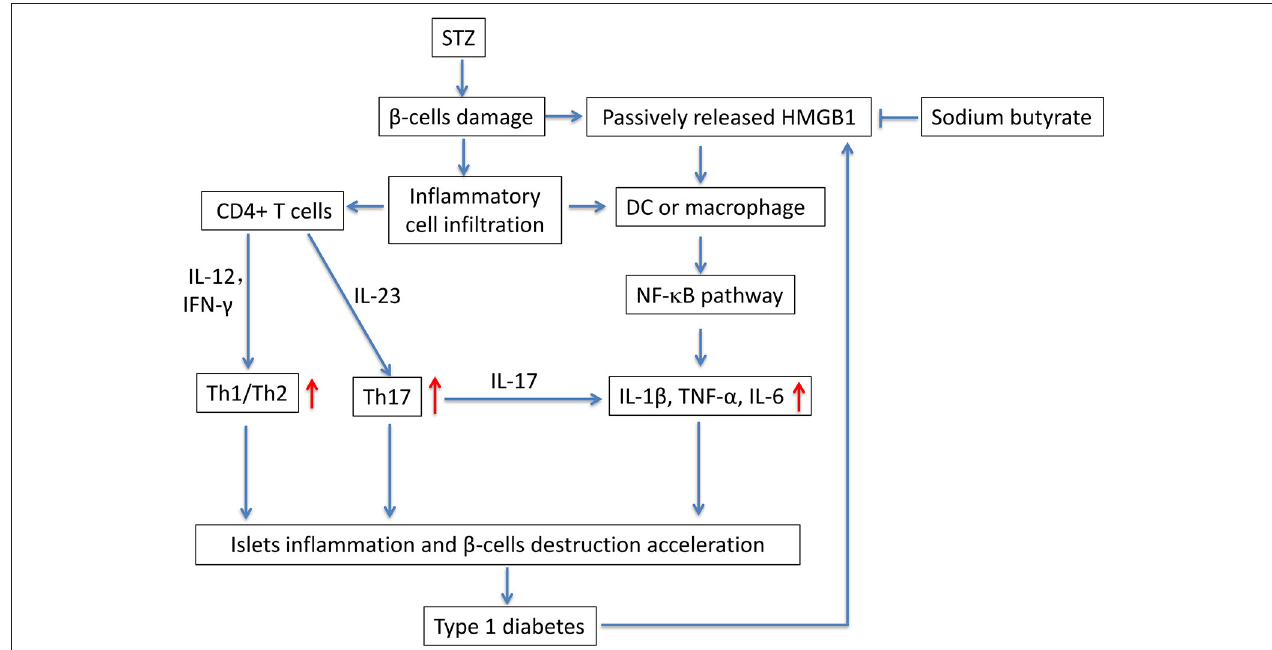
FIGURE 6 | The potential mechanism of sodium butyrate on STZ-induced type 1 diabetes. STZ, specifically destroys pancreatic β -cells. The damaged β -cells passively release HMGB1 (11). At the same time, the islets are infiltrated by inflammatory cells such as DCs, macrophages and T cells. Naïve CD4 + T cells are differentiated into effector Th1 and/or Th17 cells based on their cytokine microenvironment. In addition, the released extracellular HMGB1 targets DCs or macrophage via the corresponding surface receptor(s), induces a signaling cascade and activates NF- κ B pathway (12), therefore leading to the production of proinflammatory cytokines IL-1 β , TNF- α , and IL-6 (49). the unbalanced Th1/Th2/Th17 and proinflammatory cytokines further accelerate the islets inflammation and β -cells destruction and lead to the onset of type 1 diabetes. Sodium butyrate, as a direct HMGB1 antagonist, could down-regulate the expression of HMGB1 and mediate the balance of Th1/Th2/Th17 paradigm, thus attenuating type 1